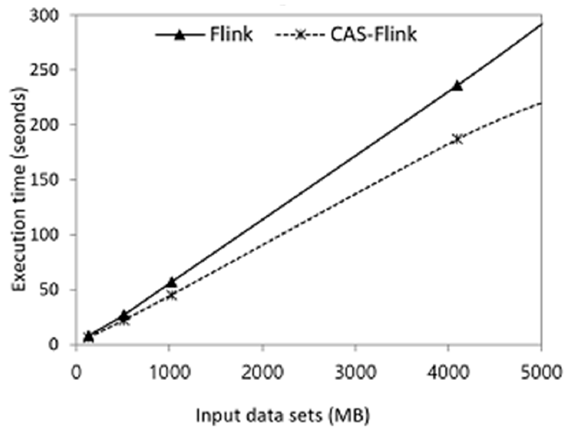
Figure 15. Flink vs. CAS-Flink: The measured performance of Flink vs. CAS-Flink, utilizing a varying volume of input datasets (adapted from [12]).